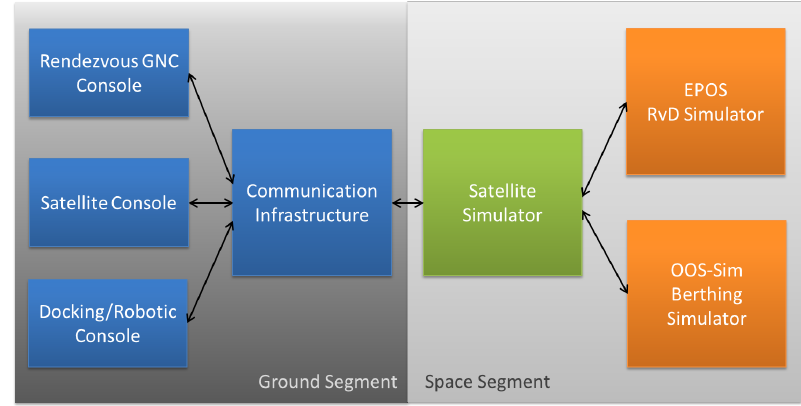
Figure 23: Overview on the elements of the On-Orbit Servicing End-to-End Simulation and their inter-